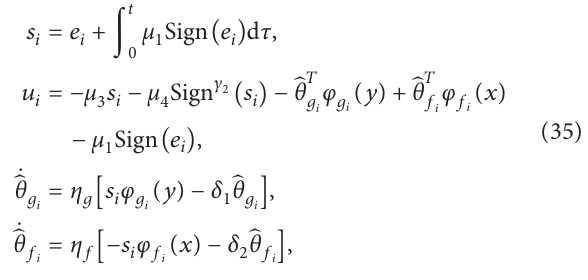
,u ,u by method (12) in time 1 2 3